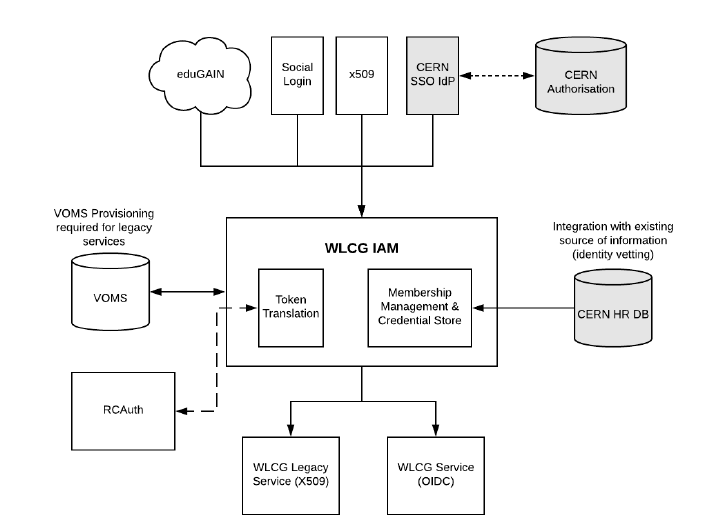
Figure 2. Design of the WLCG Token Authentication and Authorisation Infrastructure. Grey boxes represent configurable components, in this case tuned for the CERN